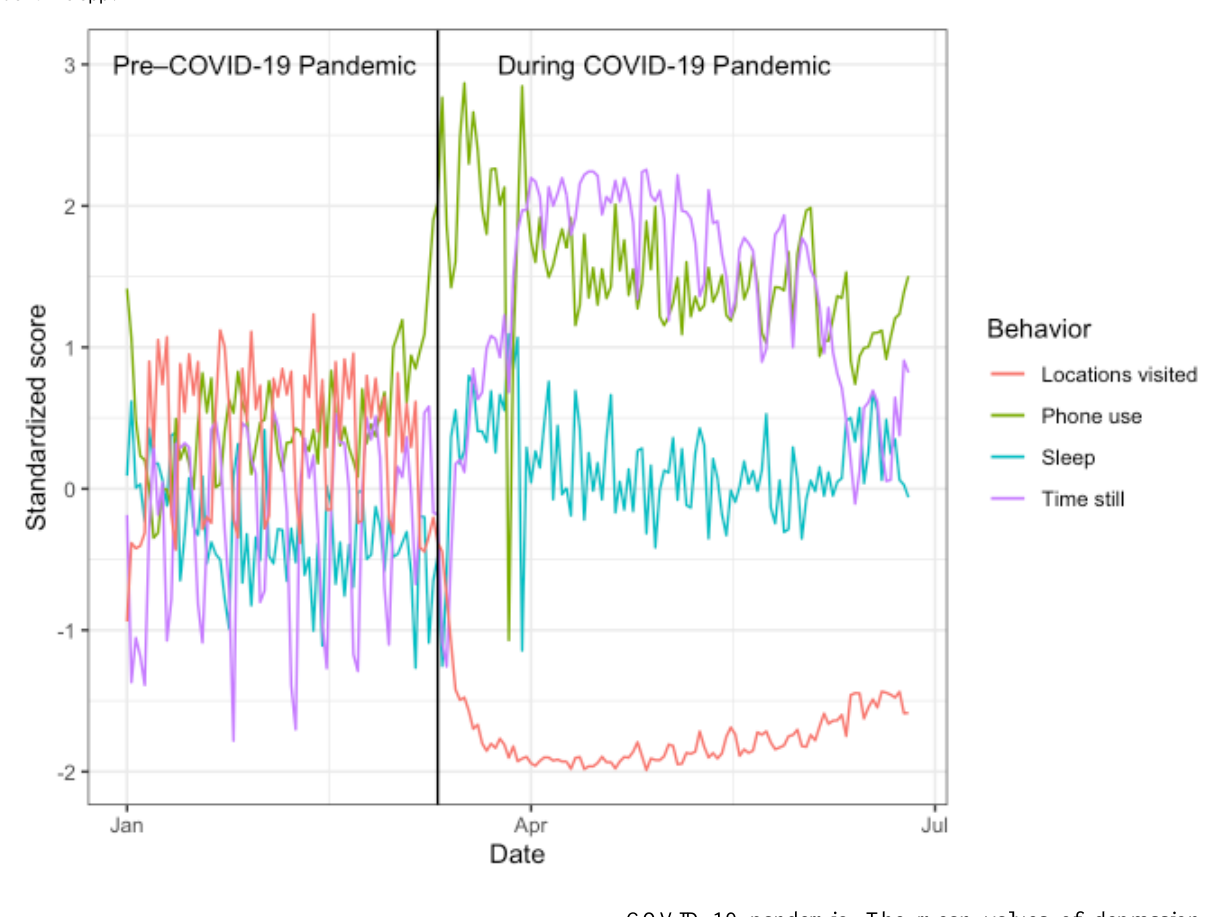
Figure 2. Standardized daily scores of the number of locations visited, duration of time phone unlocked, sleep duration, and sedentary time before and after the World Health Organization declared COVID-19 a global pandemic (March 11, 2020). All behaviors were calculated using data from the StudentLife